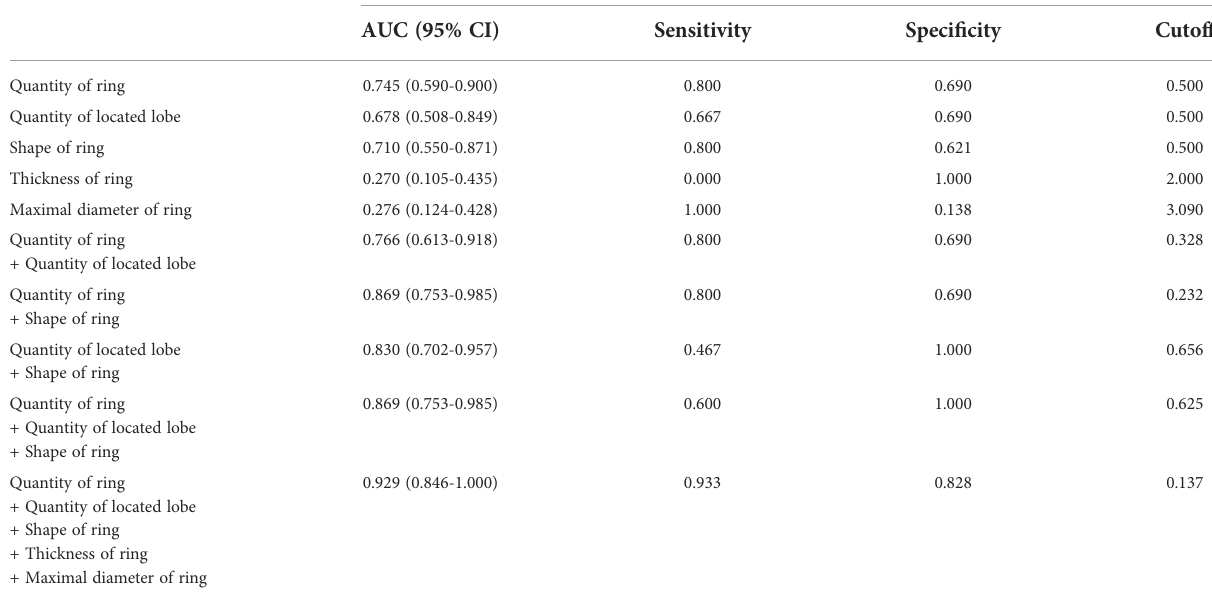
TABLE 3 Evaluation of differential diagnosis ef fi cacy for MUT BRAF and WT BRAF in